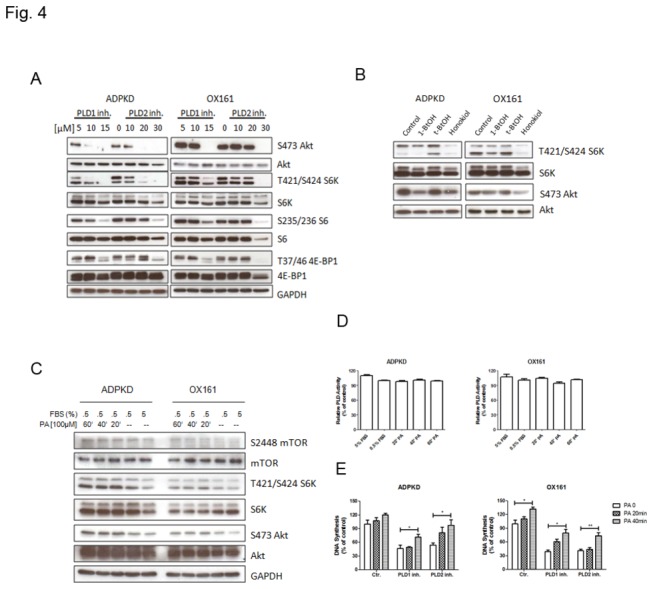
PLD inhibitors block mTOR signaling pathway and exogenous PA abrogates the effect of PLD inhibitors on mTOR signaling and proliferation of PKD cells.(A) PLD inhibitors affect mTOR signaling in a dose-dependent way. Western blots analyzing the expression of phospho-Akt, Akt, phospho-S6K, S6K, phospho-S6, S6, phospho-4EBP1, 4EBP1 and GAPDH either upon treatment with the indicated concentration of PLD1-/2- inhibitor for 48 h or without treatment. (B) PKD cells were plated for 24 h and then shifted to medium containing 0.5% serum. 1% 1-BtOH or 1% tert-BtOH was added for 2 h, 20 µM honokiol was added for 20 h. Western blots analyzing the expression of phospho-S6K, S6K, phospho-Akt and Akt. (C, D) Exogenous PA stimulated mTOR signaling in a time-dependent way, but not PLD activity. Human PKD cells were cultured under either normal culture medium (5% FBS) or starvation culture medium (0.5% FBS). After 24 h starvation, cells were treated with 100 µM PA for 20, 40 and 60 minutes. Whole cell lysates were analyzed by (C) western blots to detect the expression of phospho-mTOR, mTOR, phospho-S6K, S6K, phospho-Akt, Akt and GAPDH. (C) Whole cell lysates were determined by Amplex Red PLD kit to measure the PLD activity. (E) Exogenous PA impairs the effect of PLD inhibitors on cell growth. Cells were pretreated with either 10 µM PLD1 inhibitor or 20 µM PLD2 inhibitor for 48 h, and then with 100 µM PA for the indicated time. DNA synthesis was measured by using the BrdU assay. An experiment which is representative of three independent experiments is shown. Data are expressed as mean ± SD and were analyzed by one-way ANOVA. * p< 0.05, ** p< 0.01.